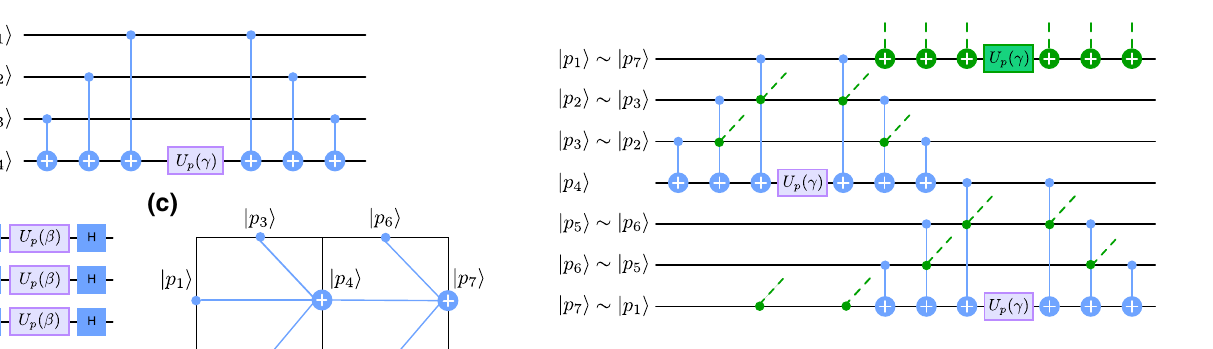
FIG. 4. Algorithm to implement the plaquette operator e i γ B on the two plaquettes depicted in Fig. 3(c). The labeling of the qubit lines emphasizes that all the boundary qubits are shared with the neighboring plaquette pairs. The partially depicted green gates (dashed lines) are related to the simultaneous implementation of the same algorithm on a couple of neighboring